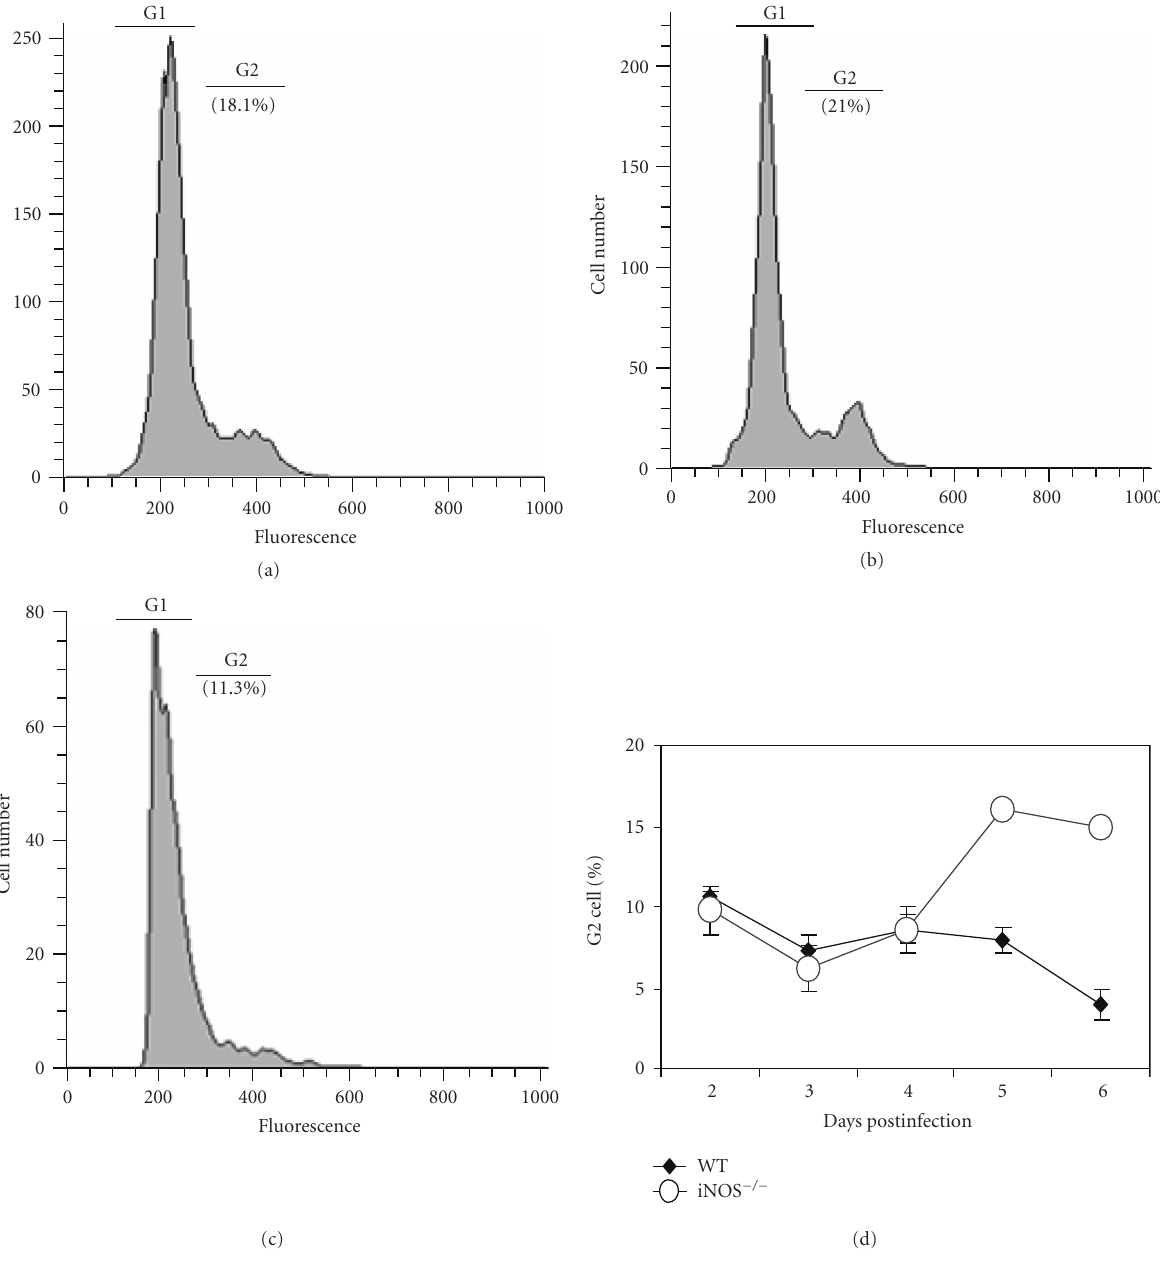
Figure 5: Higher rate of multiplication of T. congolense in infected iNOS − / − mice than in infected wild-type mice. Groups of 6 WT C57BL/6 and iNOS − / − mice were infected with 5 × 10 6 T. congolense TC13. The percentage of trypanosomes being in theG1 and S/G2/M phases was determined by DNA FACS analysis (see Materials and Methods). (a) A typical FACS DNA pattern of T. congolense freshly isolated from infected immunosuppressed mice. (b) A typical FACS DNA pattern of T. congolense in infected iNOS − / − mice at day 6 postinfection. (c) A typical FACS DNA pattern of T. congolense in infected WT C57BL/6 mice. (d) Kinetics of S/G2/M phases of trypanosomes in WT and iNOS − / − mice following TC13 infection. Note: on days 5 and 6, the trypanosomes in iNOS − / − mice had a significantly higher ratio of organisms in the S/G2/M phases than trypanosomes in WT